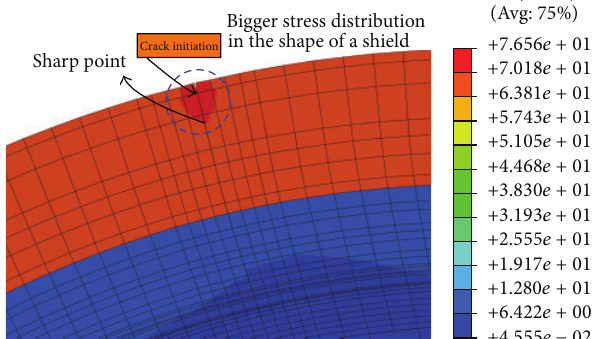
Figure 10: The Von-Mises stress distribution at the periphery of surface